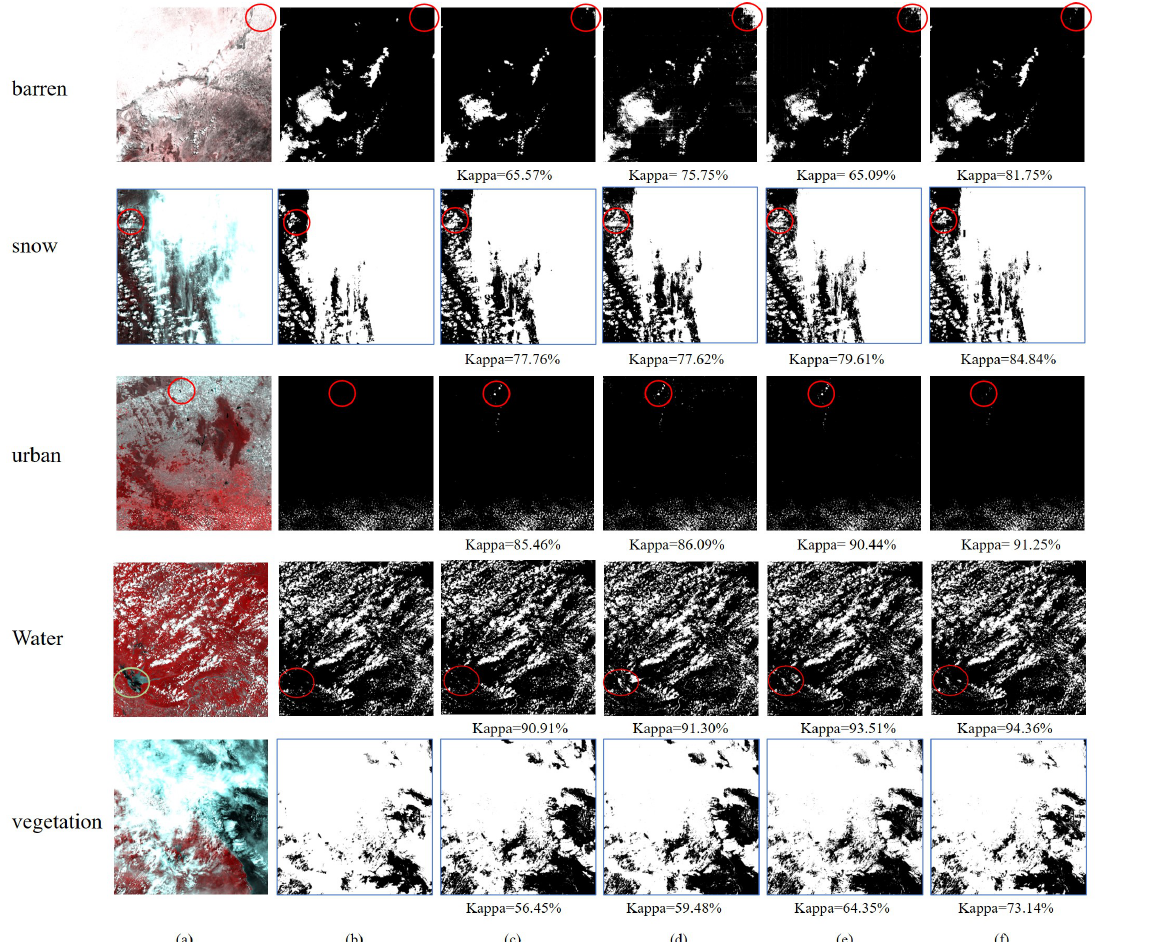
Figure 10. ( a ) NIR-R-G image, ( b ) the ground truth, and masks generated by the ( c ) SegNet, ( d ) DeepLabv3+, ( e ) RS-Net, and ( f )